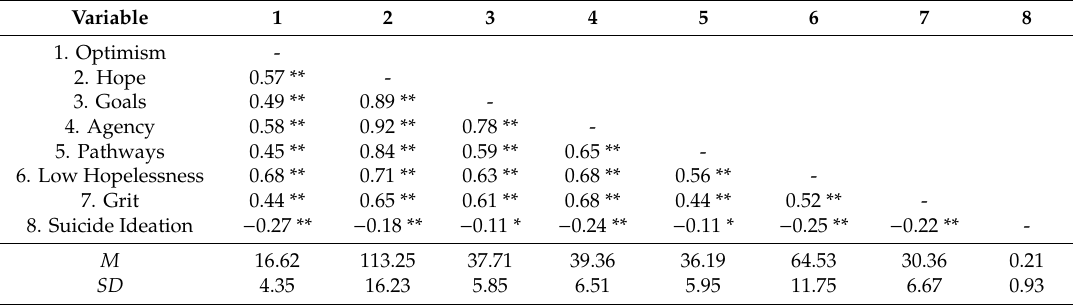
Table 1. Means, Standard Deviations, and Correlation Coe ffi cients of Optimism, Hope and its Subscales, Low Hopelessness, Grit, and Suicide Ideation. Variable